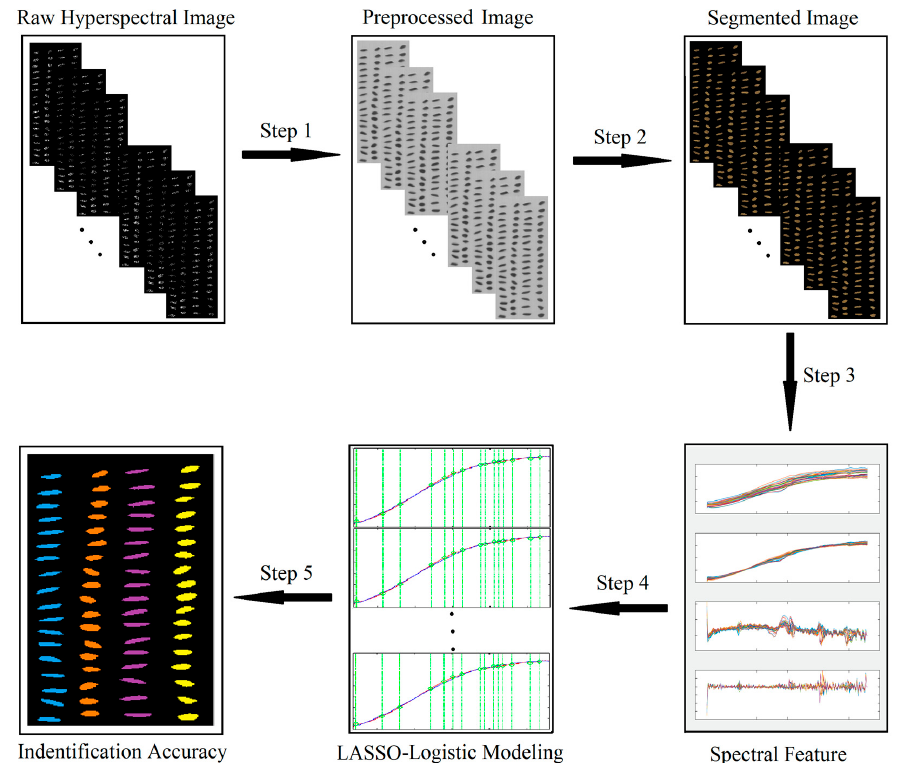
Figure 3. Flowchart of hyperspectral image processing, including data pre-processing, background segmentation, data set preparation, modelling, and identification accuracy output.